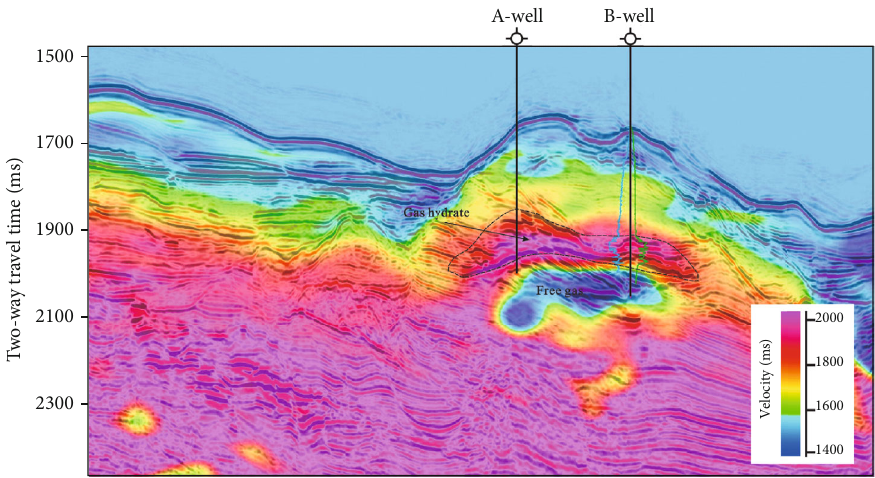
Figure 9: Well-tie P -wave velocity cross section of the A-well and B-well (according to [3]).